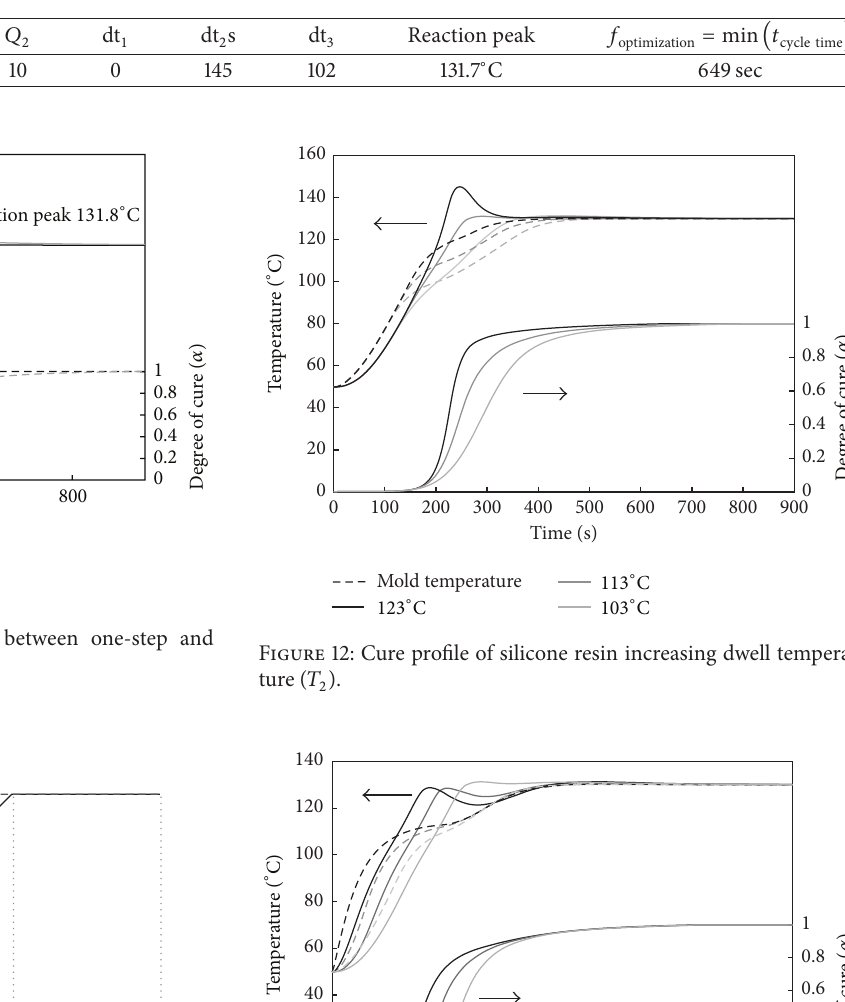
Table 3: Optimized parameters for cure cycle reduction.